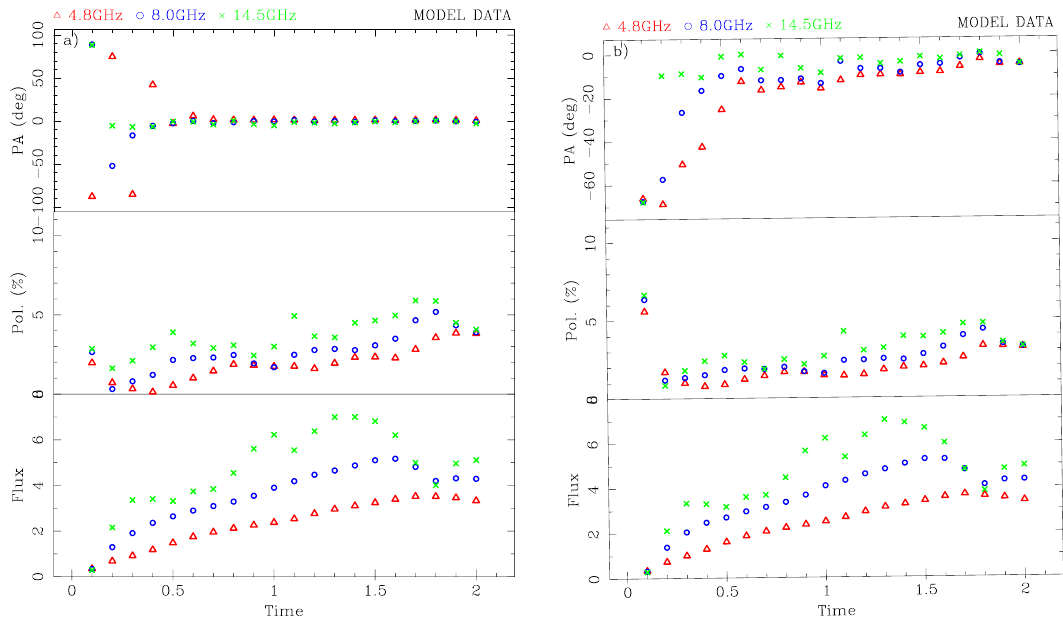
Figure 5. Simulated T1985 light curves with the addition of a weak helical magnetic field component. Panel ( a ) shows the simulated light curves for T1985 assuming a negligible helical magnetic field (an order multiple of 0.05; see text). As would be expected, this simulation is nearly identical to our adopted model (Table 1) which did not include a helical magnetic field. Panel ( b ) shows the simulated light curves for a helical field with strength approaching that of the random component (an order multiple of 0.5). Time is shown in arbitrary